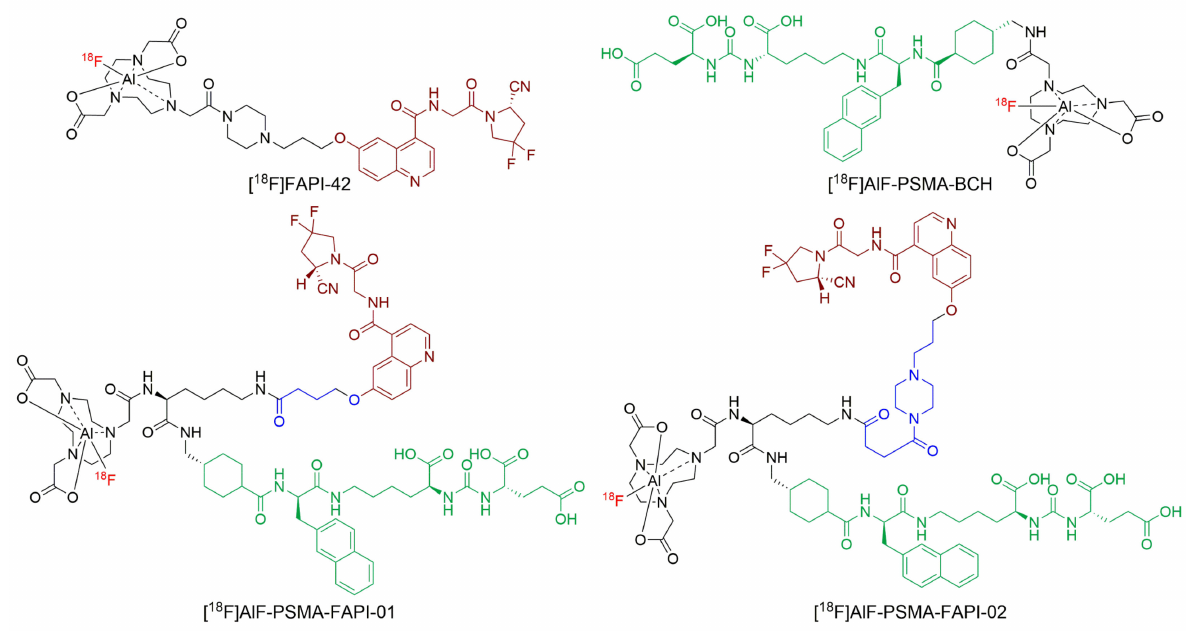
Figure 1. The structure of [ 18 F]AlF-PSMA-FAPI-01 and [ 18